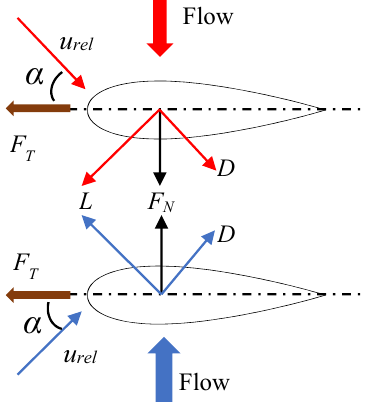
Figure 2. Forces and velocities on Wells turbine blade.